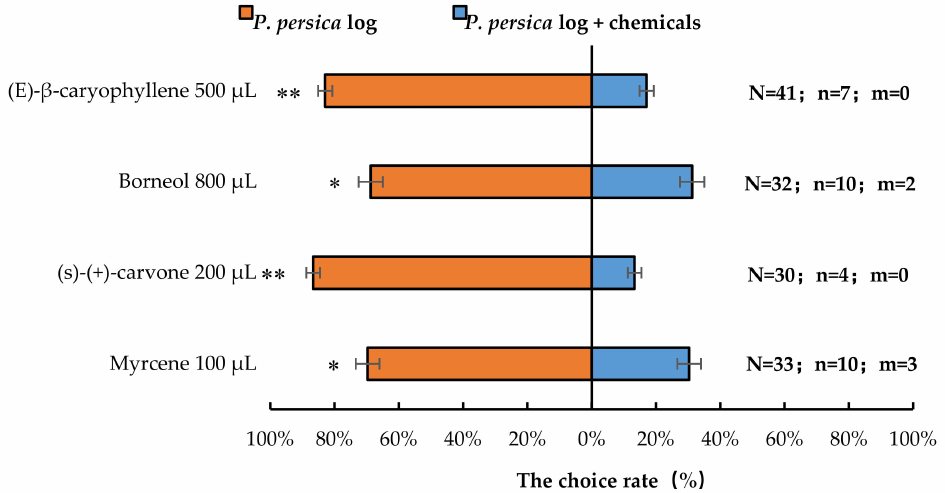
Figure 7. Behavioural responses of A. bungii females to P. persica logs in the presence of synthetic chemicals. Note: N = number of responsive A. bungii ; n = number of A. bungii females choosing the treatment; m = number of A. bungii that made no choice. * = significant difference at the 0.05 level. ** = significant difference at the 0.01 level (the binomial